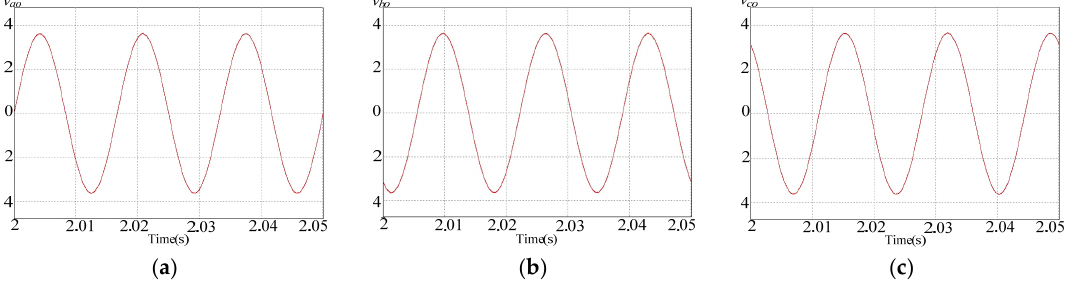
Figure 3. The output voltage waveforms of three phases of inverter operating at output voltage frequency of 60 Hz and under conditions of normal switch operation: ( a ) Phase voltage v ao ; ( b ) phase voltage v bo ; ( c ) phase voltage v co .